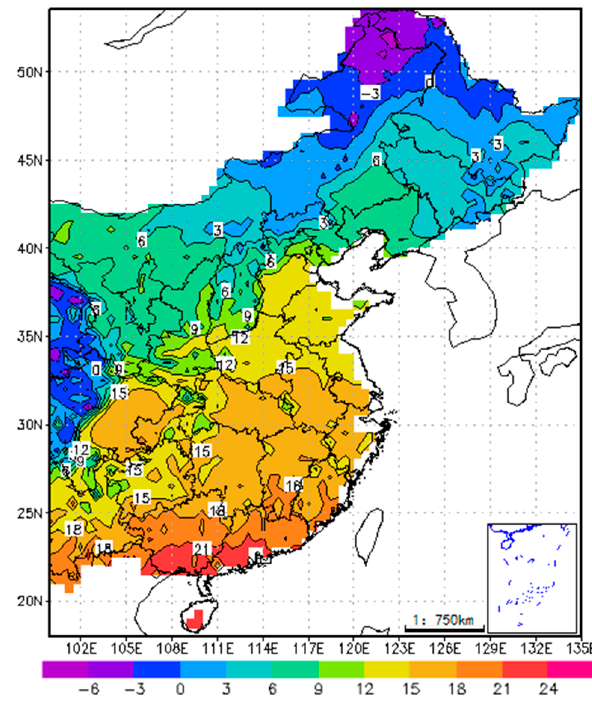
Figure 2. The national distribution of annual average temperatures from 1961 to 2011.